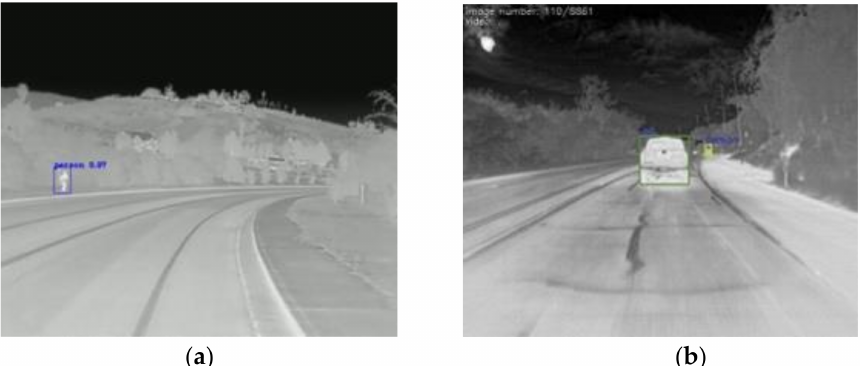
Figure 6. FLIR ADAS thermal image for walking people and cars on the road ( a ) people walking on the road marked with blue box, ( b ) Car driving on the road with green box. Teledyne FLIR LLC (2022) [22].